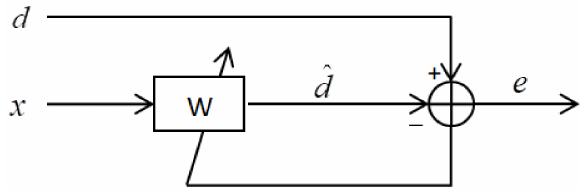
Figure 6. Structure of the LMS adaptive filter.